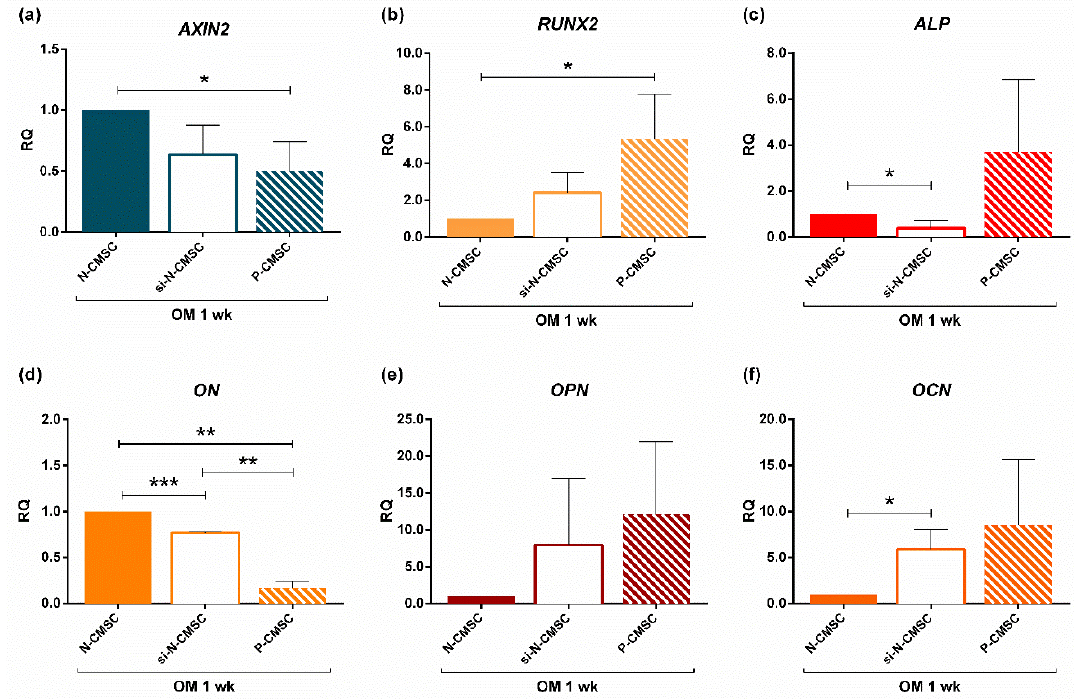
Figure 10. AXIN2 knockdown results. Expression analysis of: ( a ) AXIN2 ; ( b ) RUNX2 ; ( c ) ALP ; ( d ) ON ; ( e ) OPN; and ( f ) OCN , evaluated by qPCR upon AXIN2 silencing in N-CMSC (si-N-CMSC) cultured with osteogenic medium for one week (OM 1wk). Untreated N-CMSC were used as controls for both si-N-CMSC and P-CMSC. The graphs show the average values derived from three di ff erent experiments on three di ff erent patient’s derived cells. RQ, Relative Quantity (see Methods for details). * p < 0.05; ** p < 0.01; *** p < 0.001.